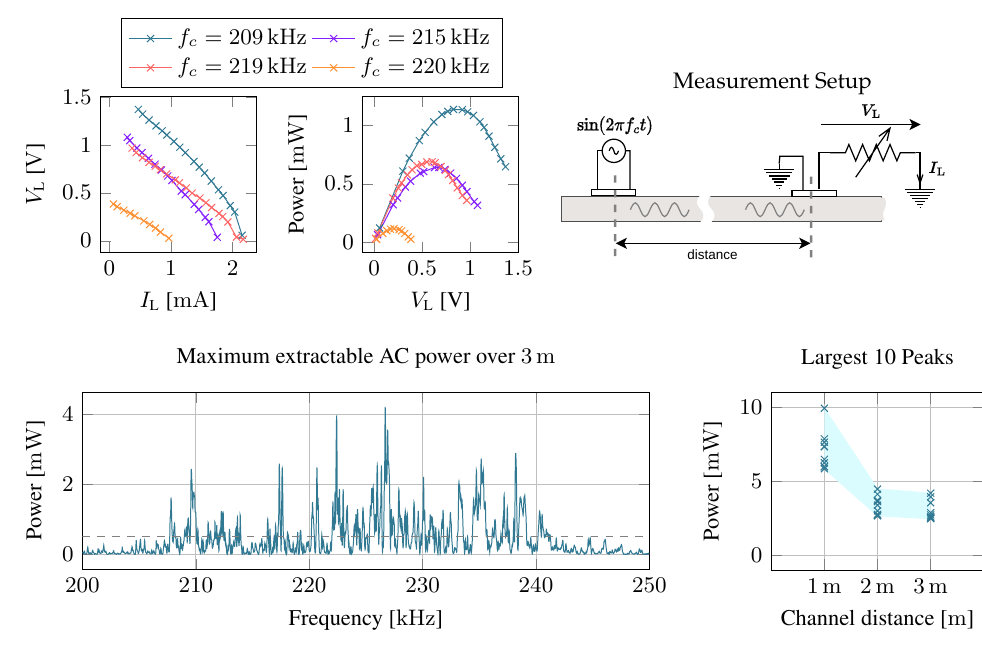
Figure 9. The maximum power point is achieved at half the open circuit voltage. Wirelessly trans- mitted power is highly frequency dependent, and the distance between transmitter and receiver is